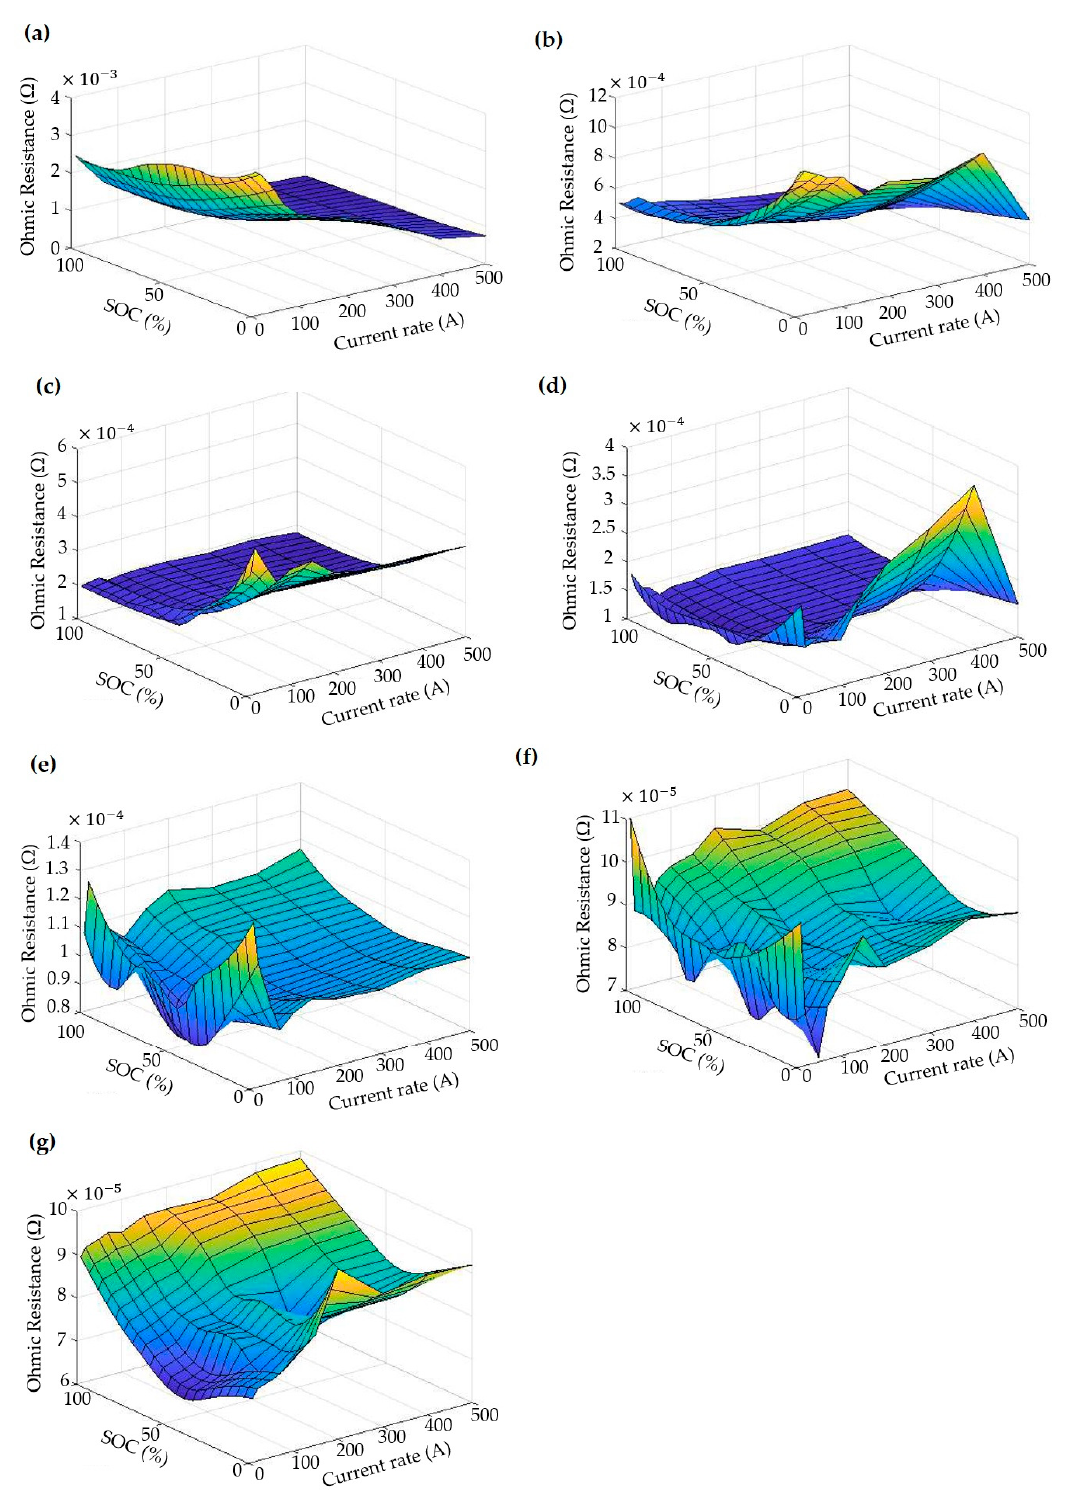
Figure 6. The behavior of ohmic resistance at different SOC and current rates: ( a ) − 10 °C, ( b ) 0 °C, ( c ) 10 °C, ( d ) 25 °C, ( e ) 40 °C, ( f ) 50 °C, ( g ) 60 °C.